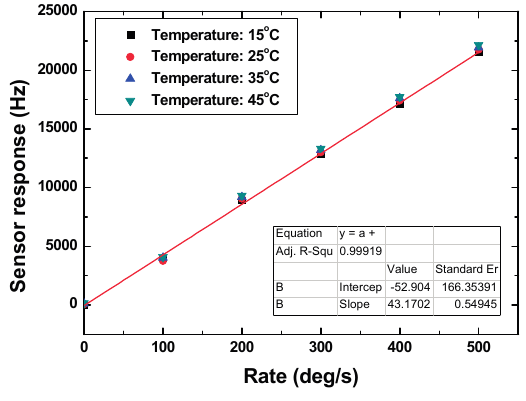
Figure 10. Testing of temperature effect on sensor